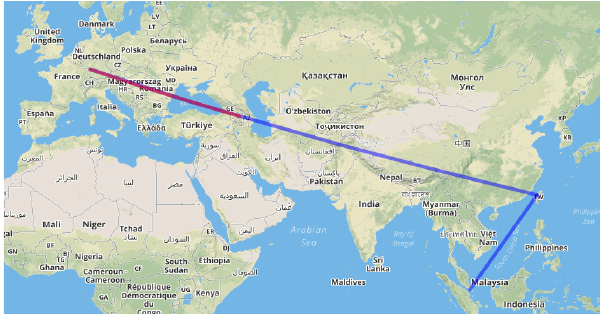
Figure 3. FCU/CODE-DE federation query path: query sent to FCU from Singapore, subquery generated for CODE-DE